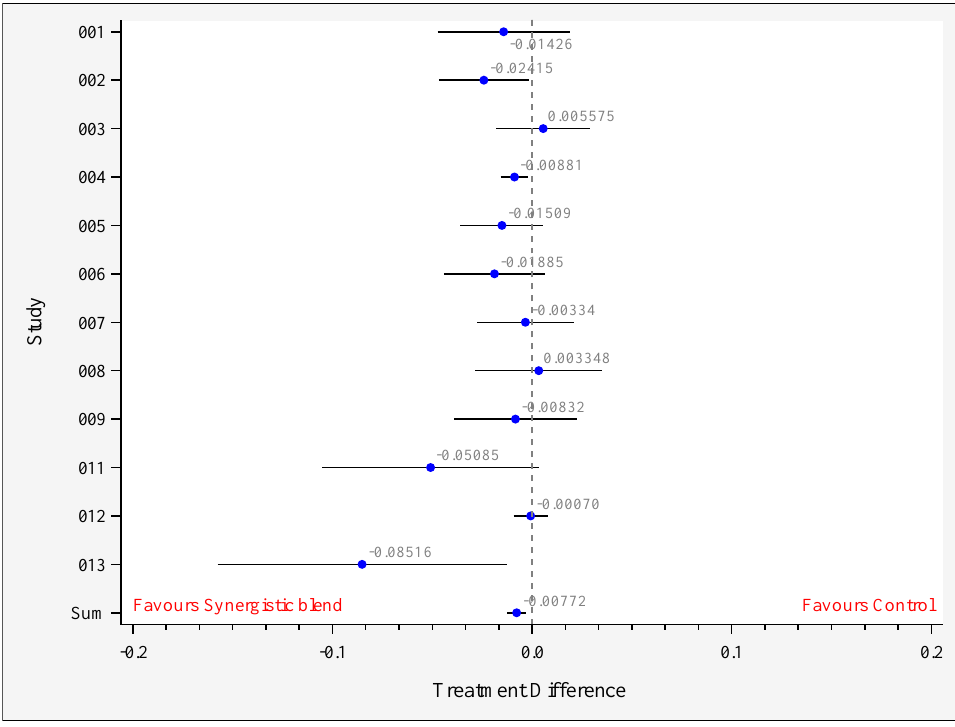
Figure 4. Forest plot for a feed conversion ratio of the overall study period between control and synergistic blend (Treatment). The circles represent the log CFU/g difference between treatments, the bars represent the 95% confidence limits and the vertical line at 0 represents the value of no difference between treatments. Legend: 0XX with XX = study number (See Table 1). Table 3. Results of the meta-analysis on growth performance for the overall study period.